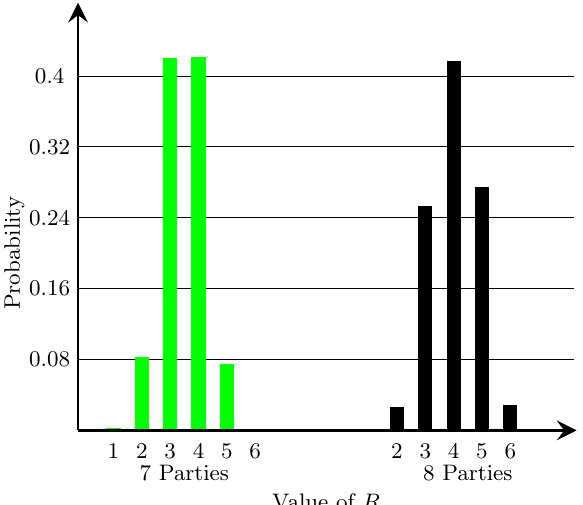
Figure 1: The distribution of the number of seats allocated from the